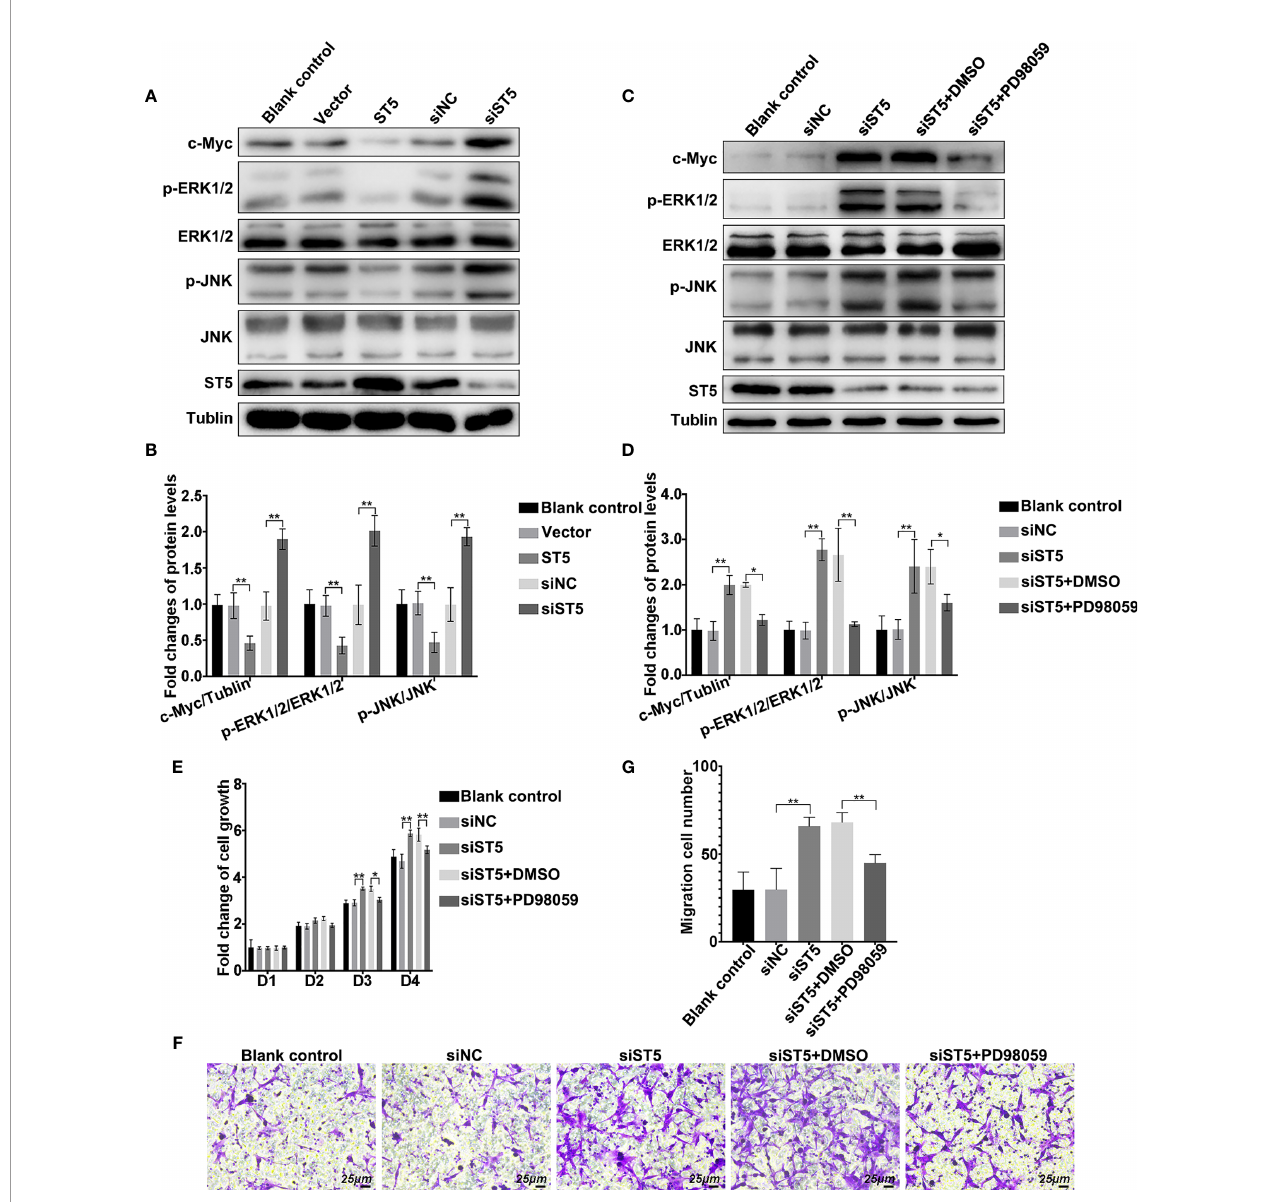
FIGURE 5 | Regulatory mechanism of ST5-mediated tumour inhibition. (A) The activation of extracellular signal-regulated kinase (ERK)1/2 and c-Jun N-terminal kinase (JNK), and the expression of c-Myc and ST5 were detected by western blotting in ST5-depleted and ST5-overexpressed MDA-MB-231 cells. (B) Relative quanti fi cation of phosphorylated ERK1/2 and JNK, and c-Myc expression in panel (A) * indicated cells transfected with ST5-overexpressing plasmid or siST5 vs. Vector or siNC, respectively. (C) MDA-MB-231 cells were transfected with siRNA of ST5 alone or the combination of siRNA of ST5 and 10 m M PD98059. The activation of ERK1/2 and JNK, and the expression of c-Myc were detected by western blotting after upregulation of ST5 in MDA-MB-231 cells. (D) Relative quanti fi cation of phosphorylated ERK1/2 and JNK and c-Myc in panel (C, E) MDA-MB-231 cells were transfected with siRNA of ST5 alone or the combination of ST5-siRNA and 10 m M PD98059. Subsequently, MTT assay was performed to measure the cell viability. (F) MDA-MB-231 cells were transfected with ST5-siRNA or the combination of ST5-siRNA and 10 m M PD98059. Cell migration was determined using Transwell assay and the migrated cells were stained by 0.1% crystal violet for 20 minutes. Scale bar, 25 m m. (G) The number of cells migrated to the lower chamber as analysed by using Image Pro Plus software. *, siST5 or siST5+PD98059 vs . siNC or siST5+DMSO, respectively. *P < 0.05, **P <